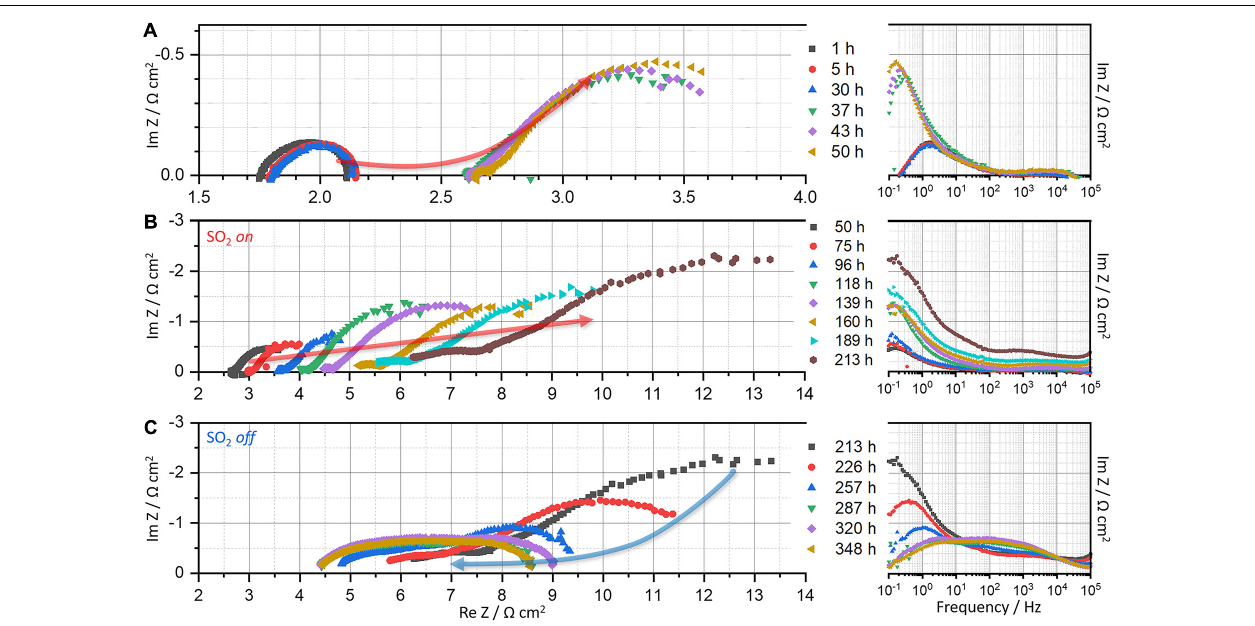
FIGURE 2 | Nyquist and bode plots of LSCF|GDC|Pt cell measured for ∼ 360 h at 700 ◦ C in alternating atmospheres of air (0–36 and 215–358 h) and 4 ppm SO 2 ( g ) (36–215 h): (A) 1–50 h, (B) 50–213 h, and (C) 213–348